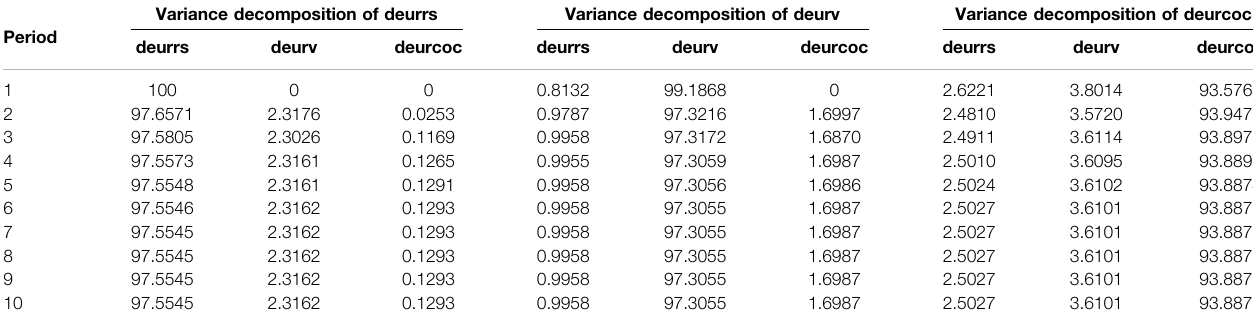
Variance decomposition of deurrs Variance decomposition of deurv Variance decomposition of deurcoc